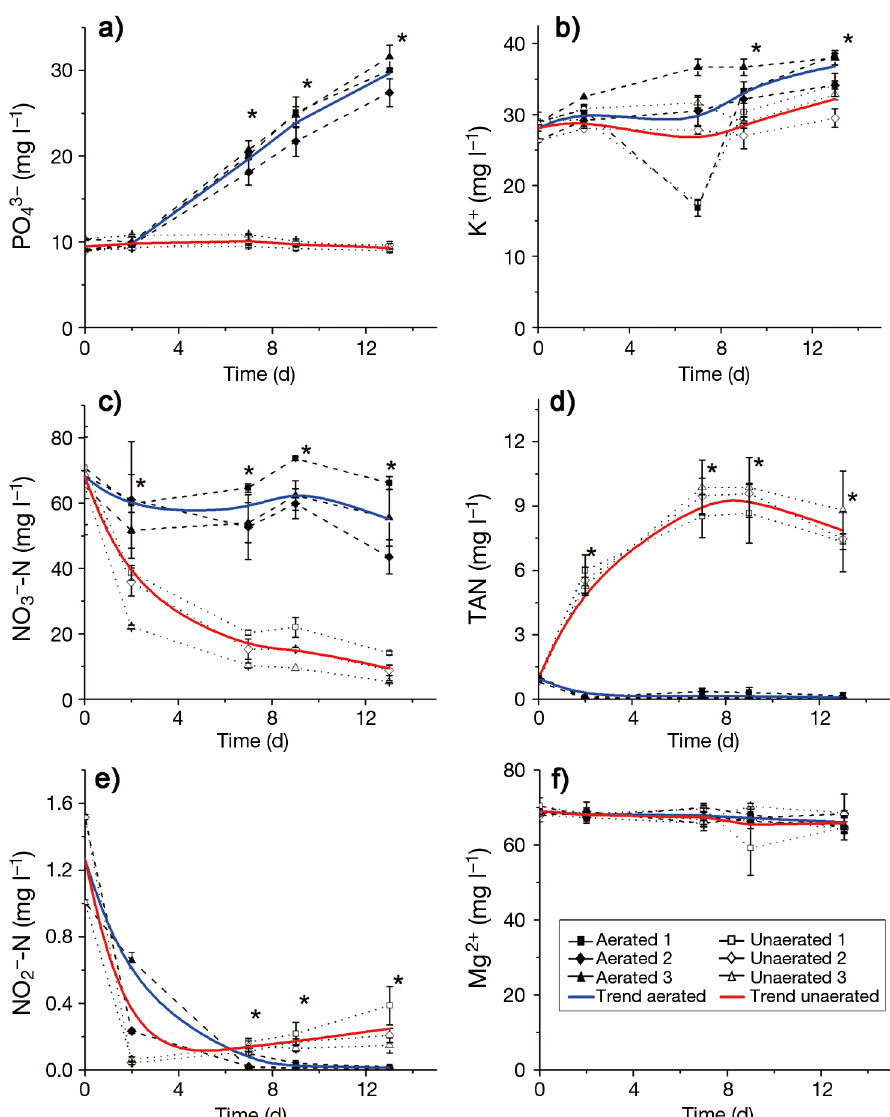
Fig. 3. Soluble nutrients (as in Fig. 2) in the liquid phase of a water-sludge mixture derived from a tilapia recirculating aquacul- ture system over 14 d (Day 0 to Day 13) of anaerobic (<0.1 mg O 2 l −1 , red) and aerobic (blue) treatment (Expt 2). Data from 3 suc- cessive trials per treatment are presented as means ± SD. Trend lines: mean of the successive trials. *Significant differences between anaerobic and aerobic mobilization (p < 0.05, Mann-Whitney U , n = 3 trials per